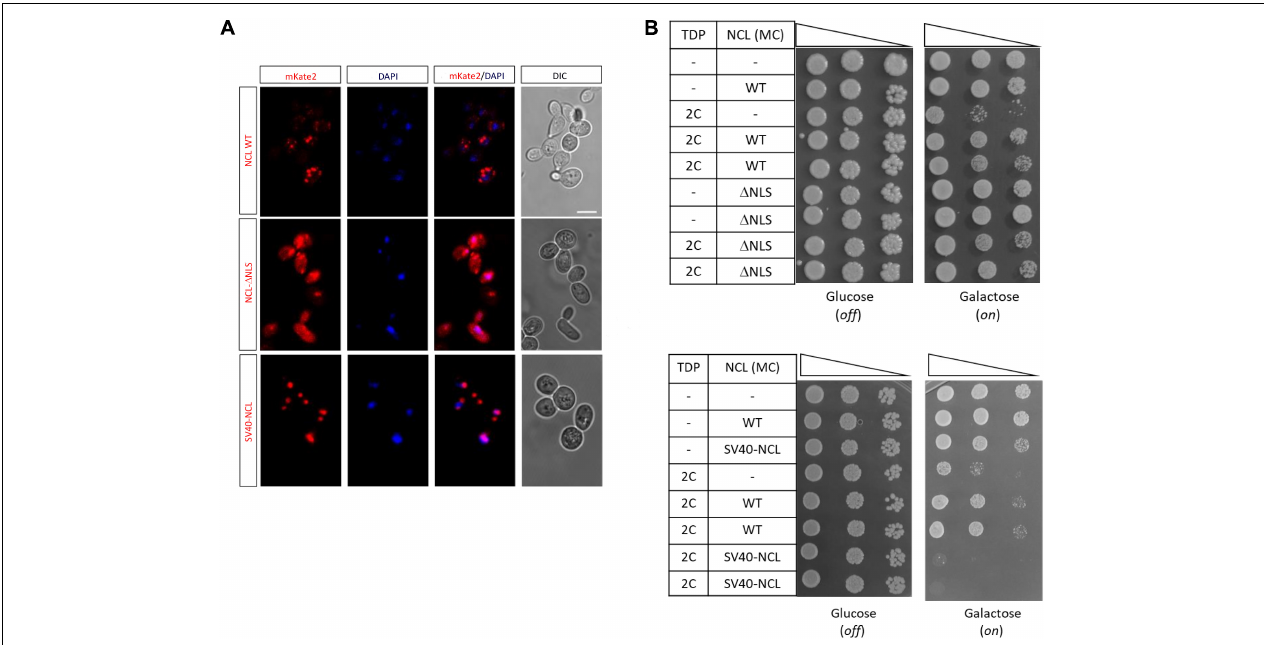
FIGURE 7 | An extra-nuclear NCL fraction is probably responsible for the rescue of TDP-43 toxicity. (A) Yeast CENPK cells were transformed with the MC plasmids coding for the mKate2 red fluorescent protein fused to either NCL full-length protein (WT), lacking the nuclear localization signal (NCL- (cid:49) NLS) or tagged with the SV40 target sequence (SV40-NCL). After 24 h incubation in inducing (galactose) medium, yeast cells were fixed, and analyzed by confocal microscopy to observe the NCL-mKate2 expression (left), the nuclear compartment (DAPI), and cell morphology (DIC, right). Images are representative of three biological replicates for each strain. Scale bar, 5 µ m. (B) Yeast strains carrying two genomic copies of TDP-43 transgene (TDP 2C), or unmodified CENPK (–), were transformed with MC plasmids driving the overexpression of NCL, either WT, lacking the nuclear localization signal ( (cid:49) NLS, upper panel), or fused to the SV40 sequence (SV40-NCL, bottom panel). Yeast cells (OD 600 = 1) of each strain were serially diluted (10-fold) and spotted onto either inducing medium plates (galactose, expression on), or repressing condition as control (glucose, expression off), and incubated at 30 ◦ C for 5 days. Data are representative of 3 experiments yielding comparable